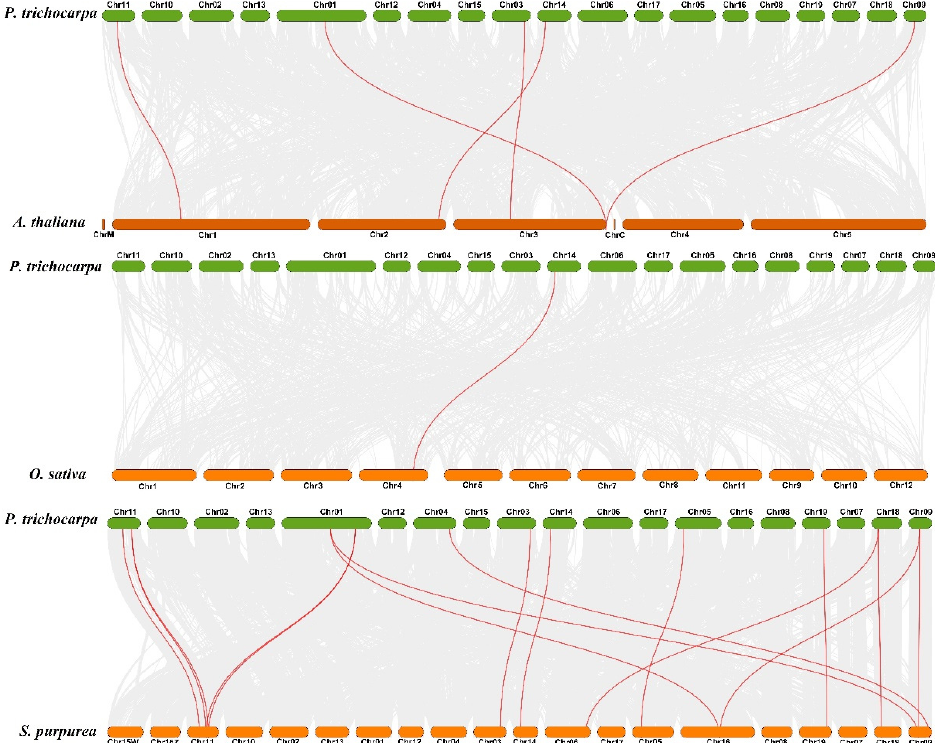
Figure 4. Analysis of collinearity among poplar, Arabidopsis, rice, and willow CCD genes. All putative orthologous genes were represented using gray curves, and the orthologous CCD genes among the genomes of poplar, Arabidopsis, rice, and willow were displayed using red curves.